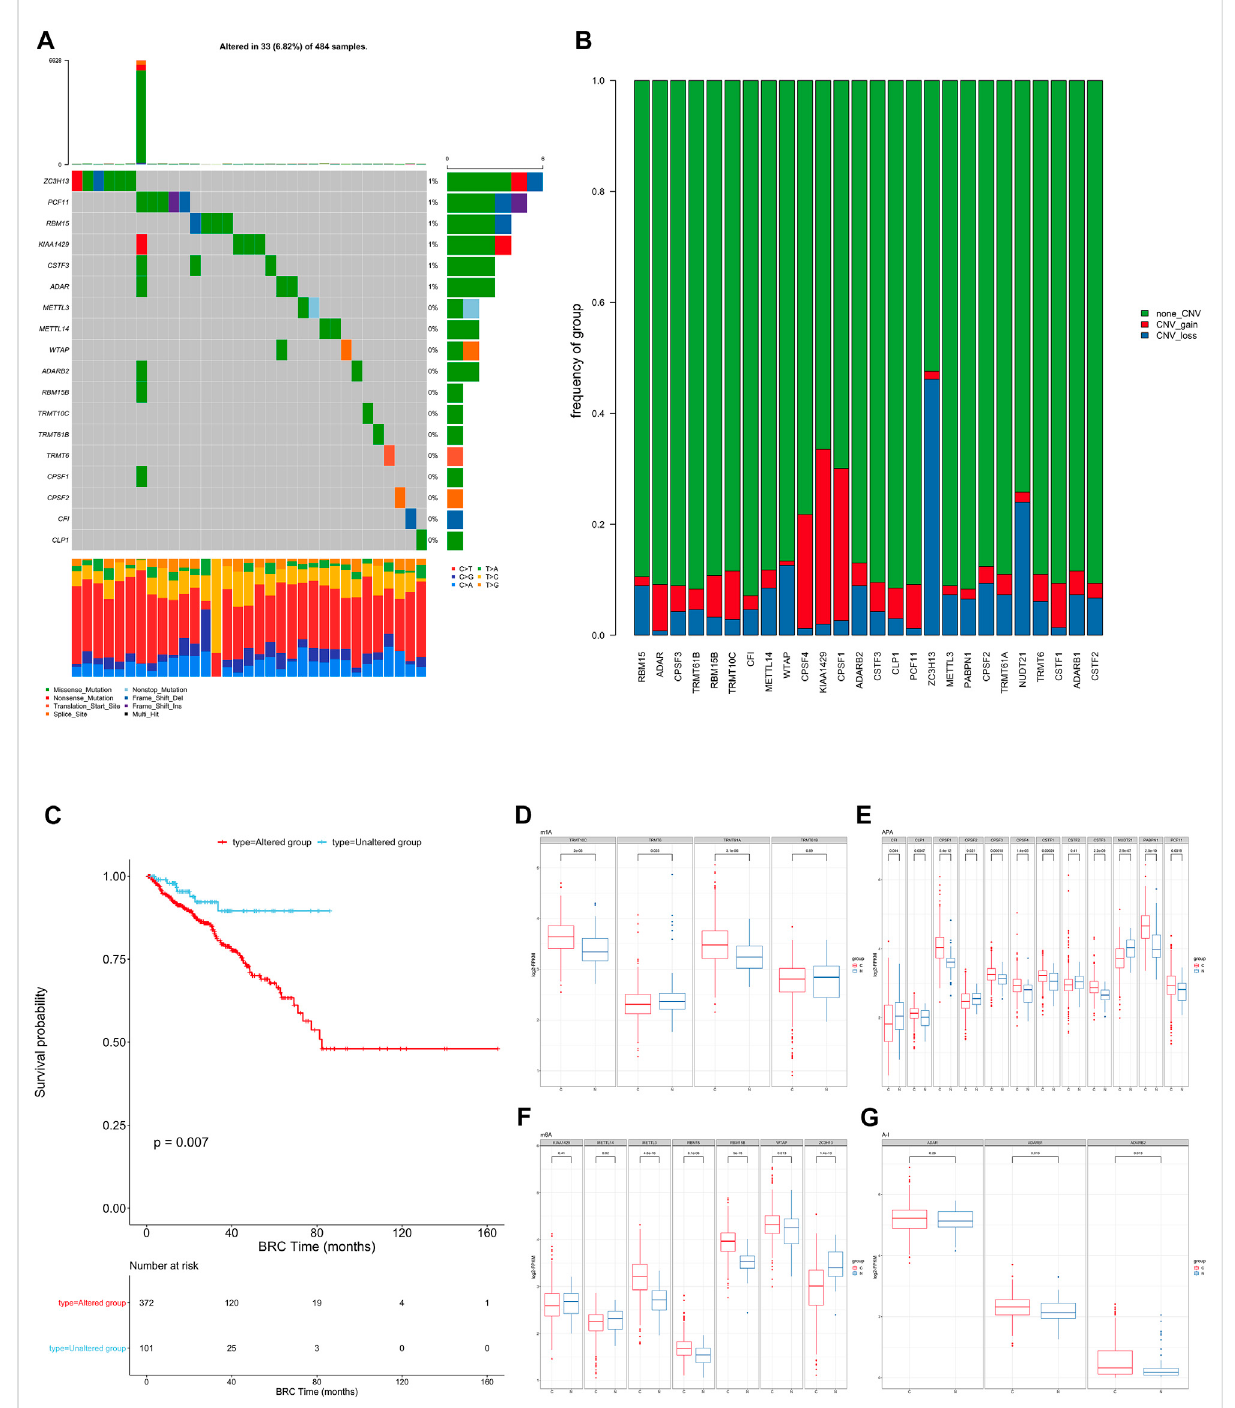
FIGURE 1 (A) The mutation frequency of RNA modi fi cation “ writers ” in 484 patients from the TCGA cohort. Each column represents individual patients. TheupperbargraphshowsTMB;thenumberontherightindicatesthemutationfrequencyineach “ writer ” .Therightbargraphshowstheproportion of each variant type. The stacked bar graph below shows the fraction of conversions in each sample. (B) Bar graphs showing the frequency of CNV gain (red), loss (blue) and non CNV (green) of RNA modi fi cation “ writers ” in the TCGA-PRAD cohort. The height of each bar represents the alteration frequency. (C) Kaplan-Meier curves show overall survival of patients with (red) or without (blue) mutations in RNA modi fi cation “ writers ” in the TCGA-PRAD cohort. The grouping of PC samples is indicated at the bottom of the chart. P < 0.05 in the two-sided log-rank test was considered statisticallysigni fi cant. (D – G) .Boxplotsshowtheexpressiondistributionof26 “ writers ” of4typesofRNAmodi fi cationbetweenpairednormal (blue) andcancer(red)tissues. Theboxesindicatethemedian±1quartile,withthewhiskersextendingfromthehingetothesmallestorlargestvaluewithin 1.5× IQR from the box